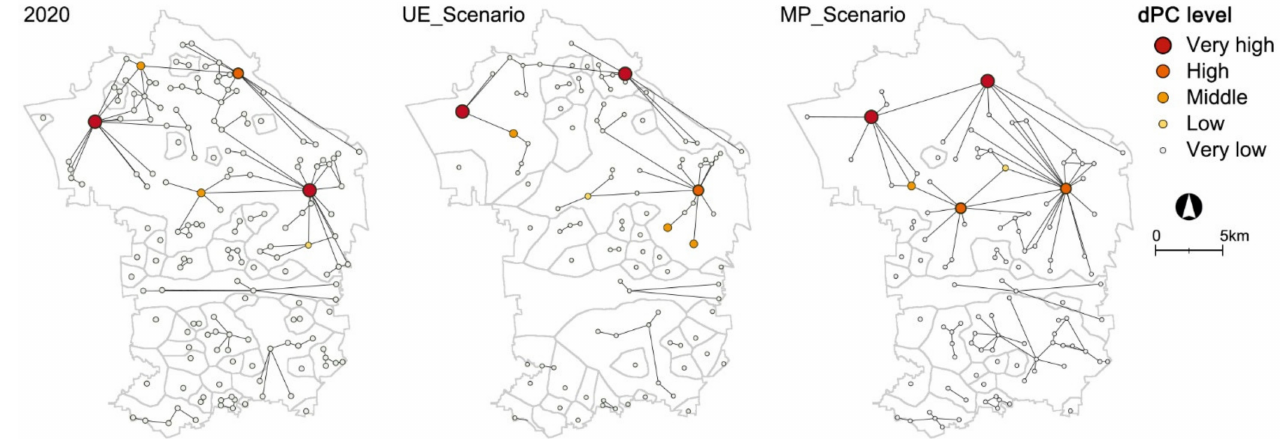
Figure 3. dPC level of patches in 2020 and under two